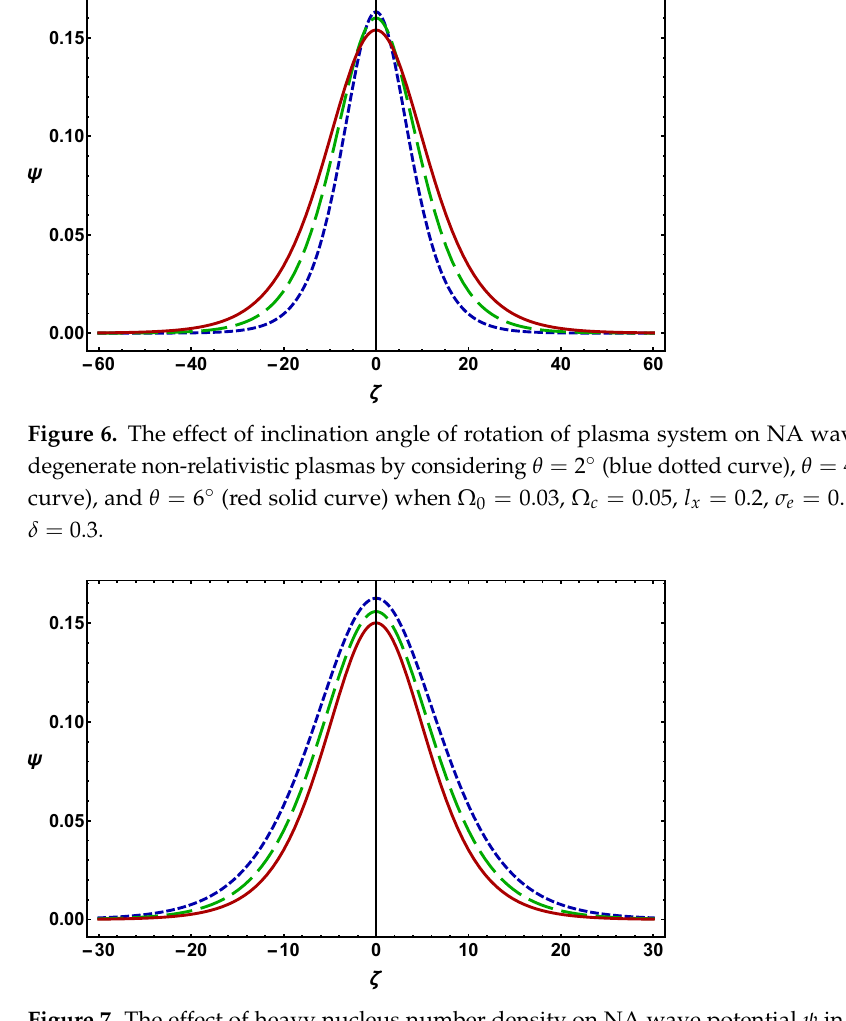
Figure 7. The effect of heavy nucleus number density on NA wave potential ψ in degenerate non- relativistic plasmas by considering δ = 0.3 (blue dotted curve), δ = 0.5 (green dashed curve), and δ = 0.7 (red solid curve) when Ω 0 = 0.03, Ω c = 0.05, l x = 0.2, σ e = 0.1, σ Te = 0.1, and θ = 5 ◦